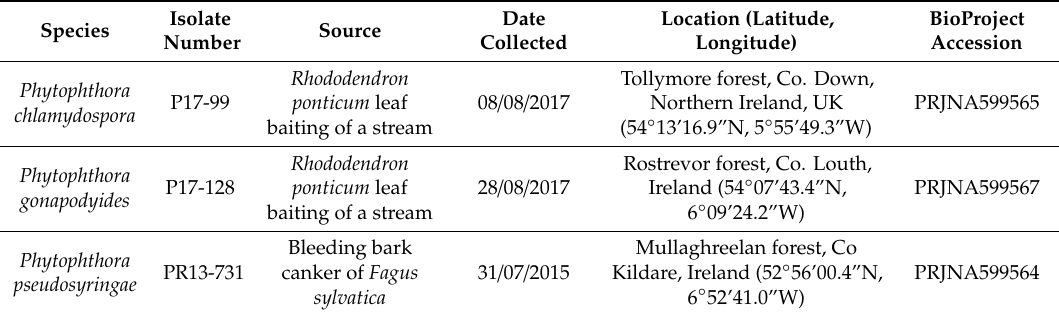
Table 1. Details of the isolates used in this